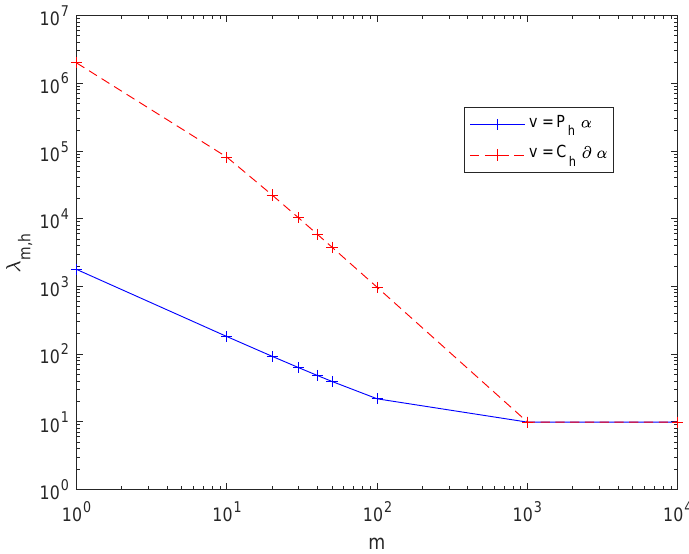
Figure 3. λ m , h against number of iterations for h = 10 − 3 and both v = P h α , v = C h ∂α